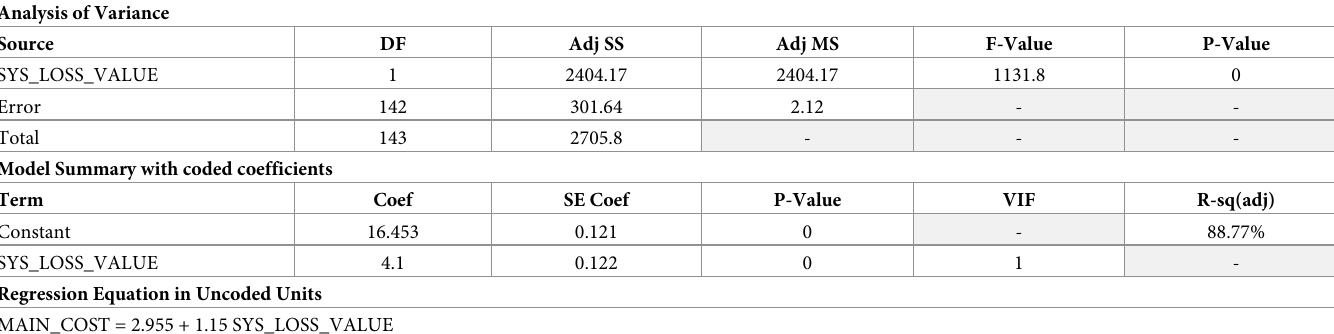
Table 4. Main cost: Fixed-wheel turn. Analysis of